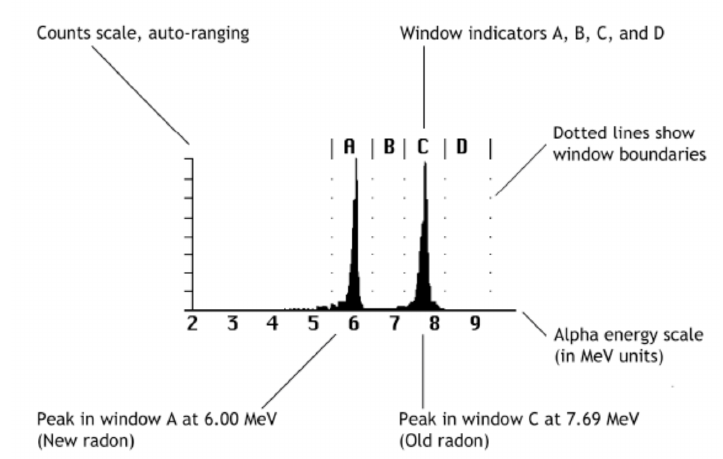
Figure 3. Alpha energy spectrum for alpha-emitting short-lived 222 Rn progeny: 218 Po (peak A) and 214 Po (peak C) at the secular equilibrium (modified from